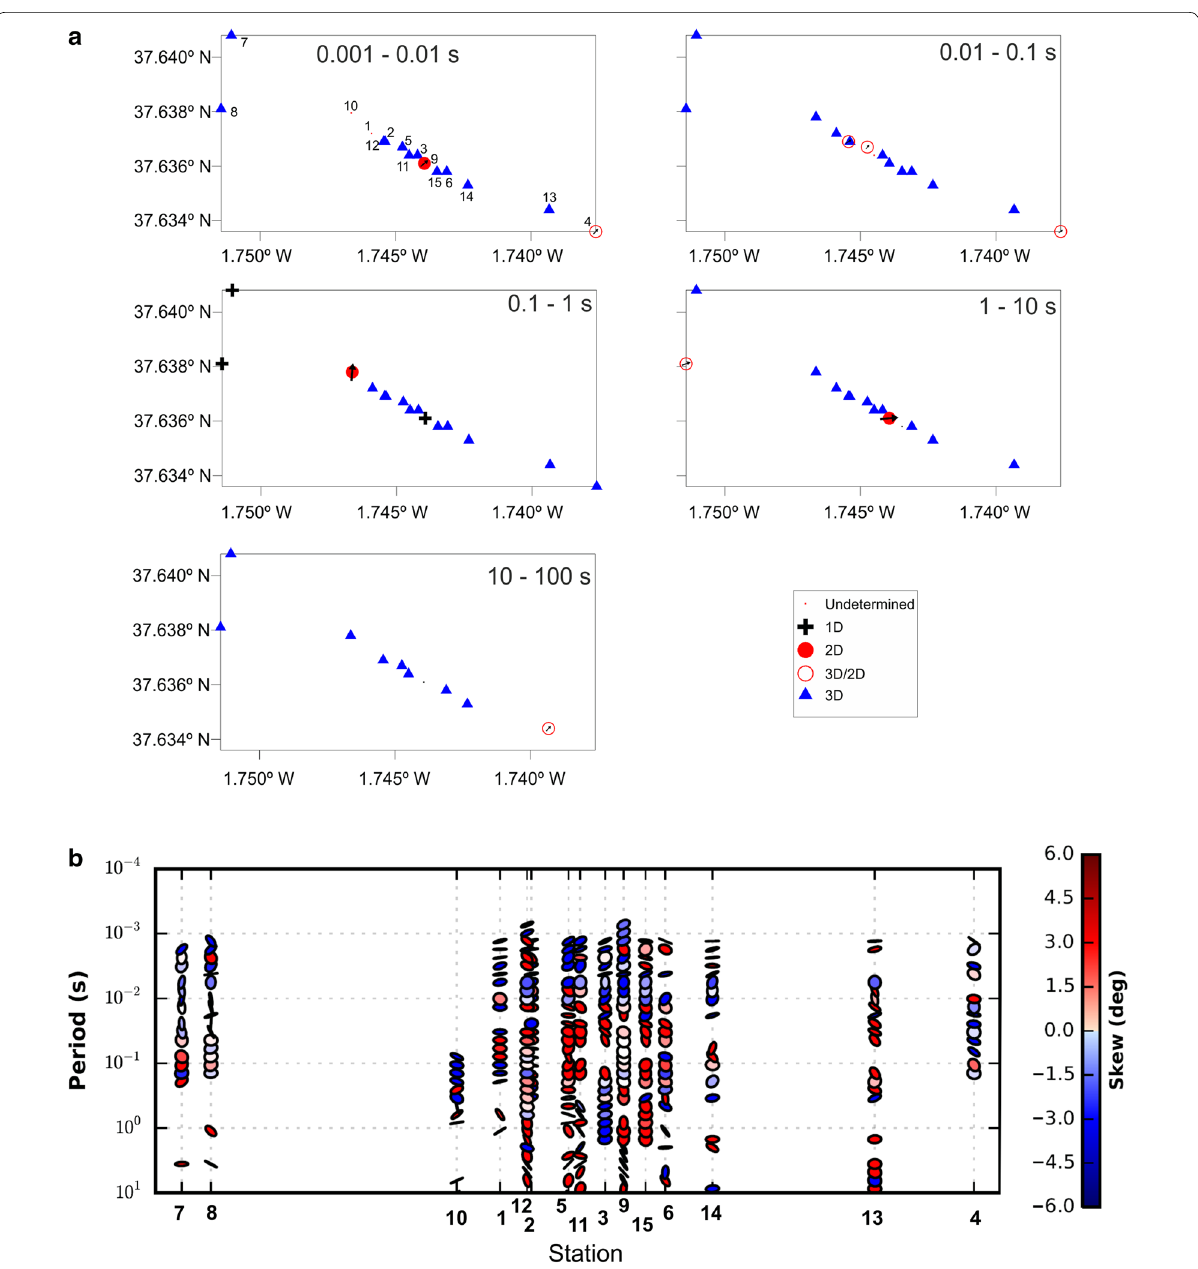
Fig. 7 a Geoelectrical dimensionality maps obtained from the WALDIM code (v1.1) averaged over five period bands for the La Torrecilla survey. Black arrows indicate the strike direction where the structure is 2D or 3D/2D and their size is inversely proportional to its error. b Phase tensor ellipses for each site and period. The color of the ellipses represents the value of the skew